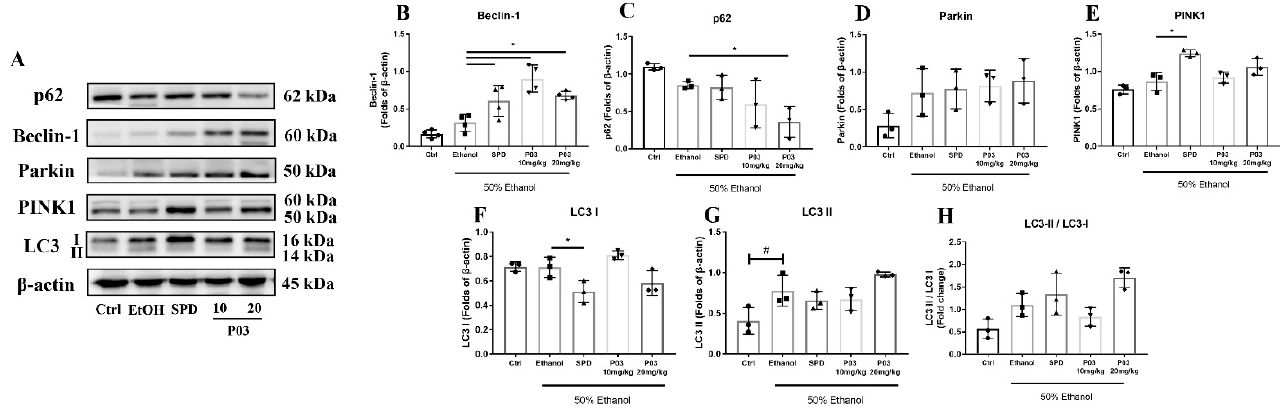
Figure 10. Immunoblots of mitophagy-related proteins. ( A ) Immunoblots of indicated proteins. ( B – H ) Densitometric quantification of p62, Beclin-1, Parkin, PINK1 and LC3 (I, II) were performed and normalized to β -actin levels. The values are represented as triplicate experiments ± SD and plotted as fold-change. (Compared to Ctrl, # p < 0.05. Compared to ethanol, * p < 0.05) ( n = 3).